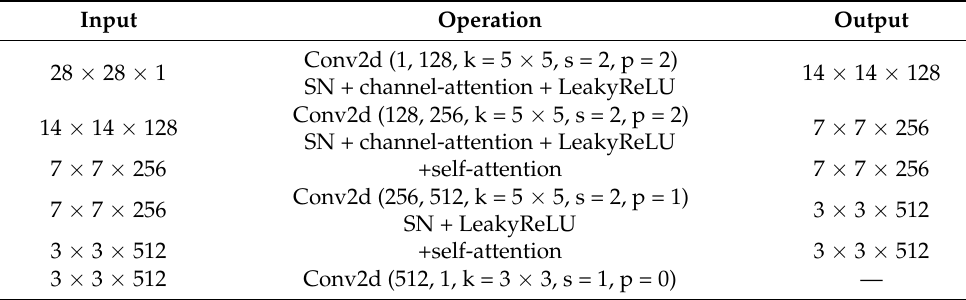
Table 6. The network structure of the discriminator in MNIST.